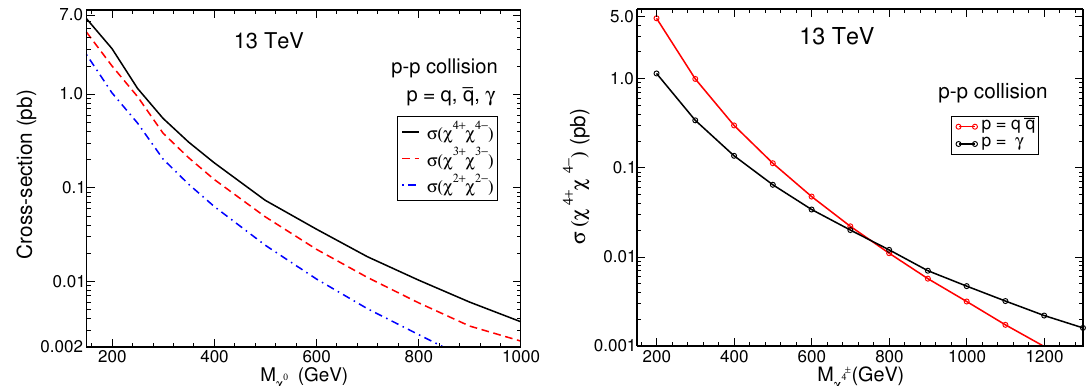
Figure 3 . Left panel shows the total cross-section of di(cid:11)erent production modes as a function of the neutral component’s mass ( M ) at 13 TeV when both quarks and photons are considered at the (cid:31) 0 initial states. The cross-section of other production modes are negligible. In the right panel, we give the cross-sections to produce a pair of quadruply charged particles as a function of its mass ( M at 13 TeV. We show it separately for two di(cid:11)erent initial states (quark-antiquark and photons).